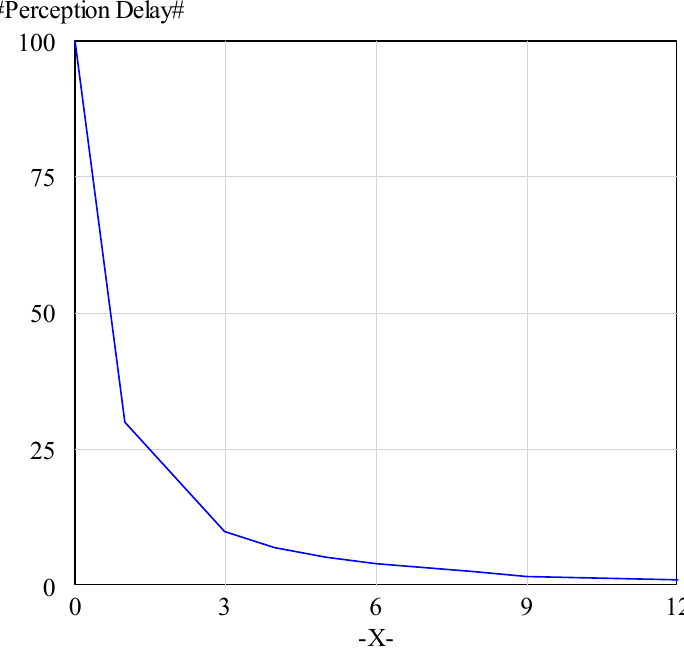
Figure A3. The relationship between perception delay ( y axis) and monitoring frequency ( x axis).